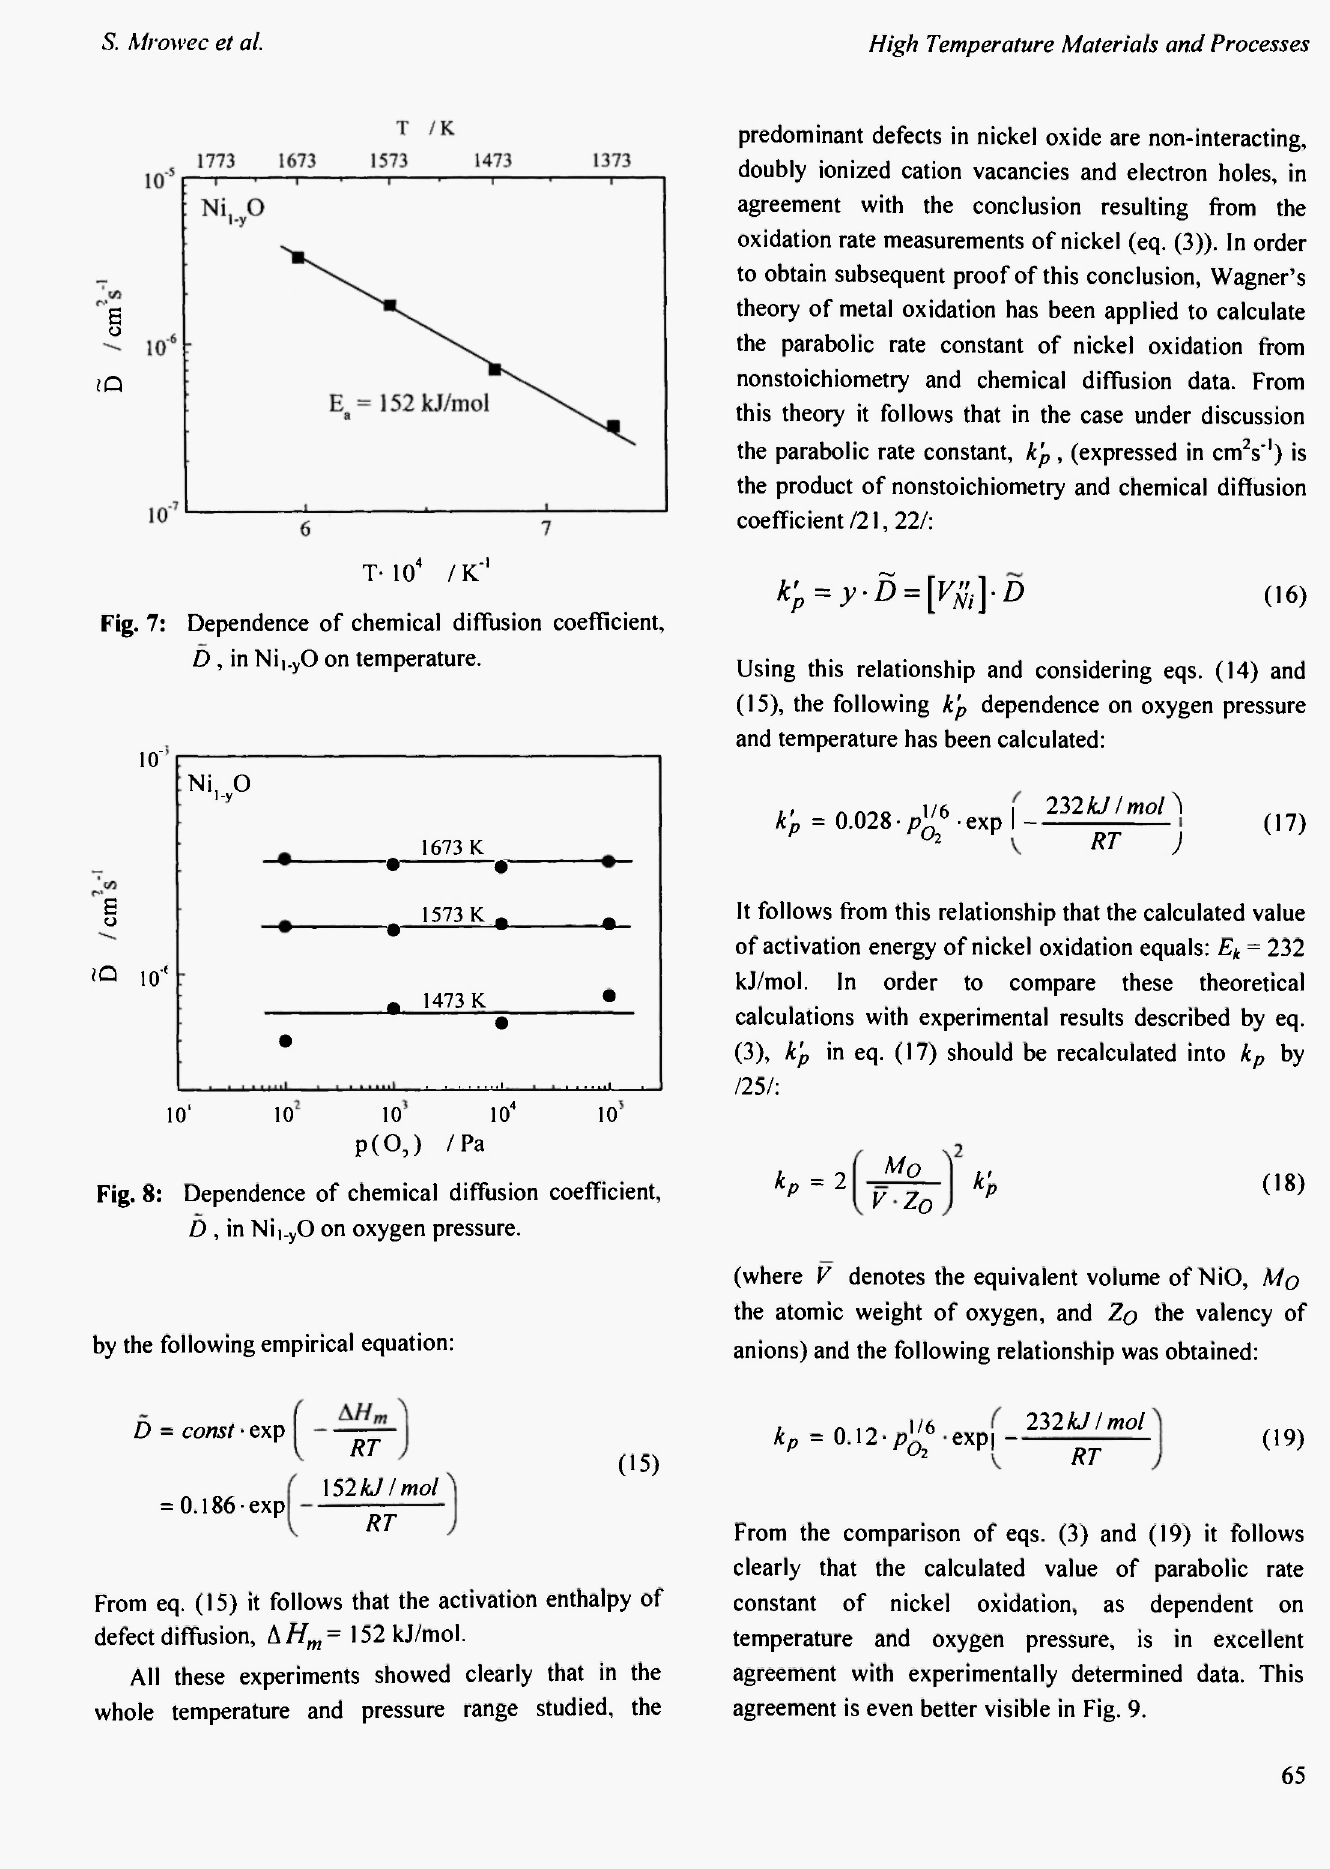
Fig. 7: Dependence of chemical diffusion coefficient, D , in Ni|. y O on temperature.